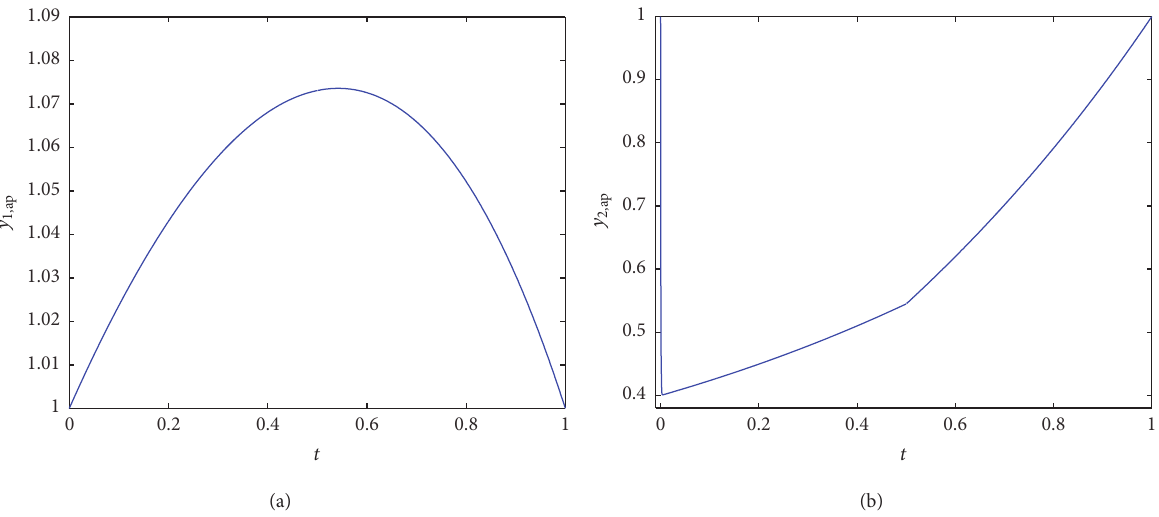
Figure 3: Graphs of the approximate solution 𝑦 1, ap and the second derivative 𝑦 2, ap for Example 3 at 𝜀 = 2 −9 and 𝑁 = 5 .